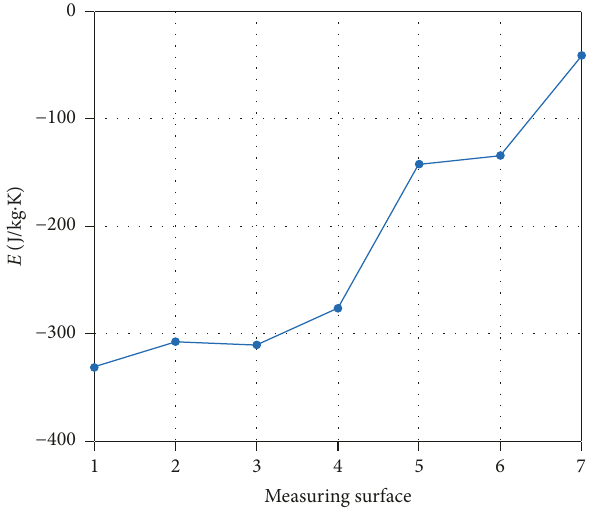
Figure 12: Entropy at each measuring surface.